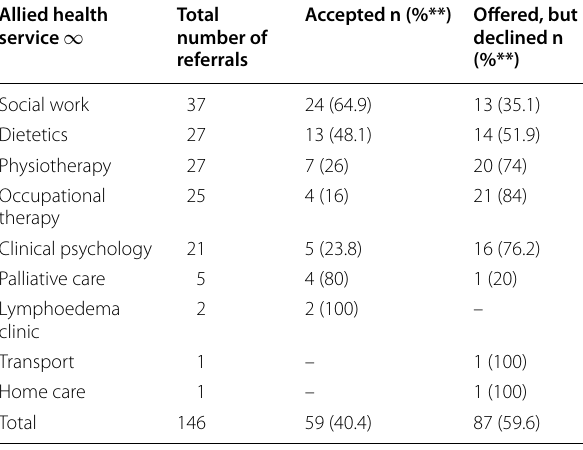
**Based on the total of referrals within each category Multiple referrals can be made/attempted after a breach in a single action/ ∞ phone call